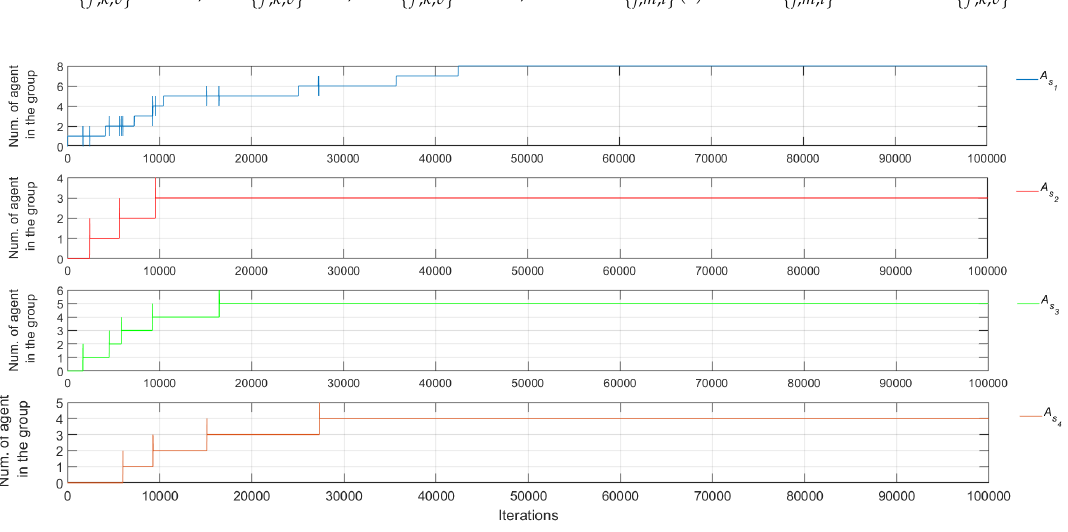
Figure 17. The number of agents in the groups operating in the individual subspaces of the multi-environment space (Figure